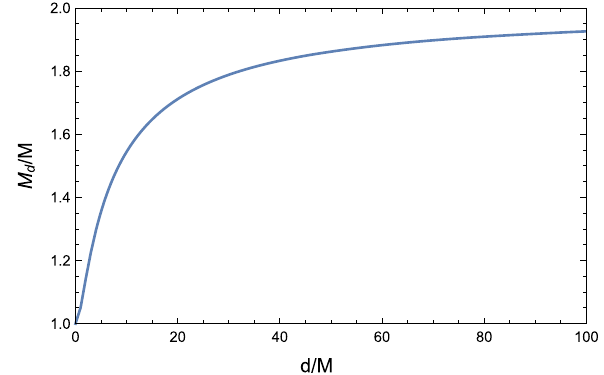
Fig. 1 Monopoliummass M d / M asafunctionofthedistancebetween the poles d /